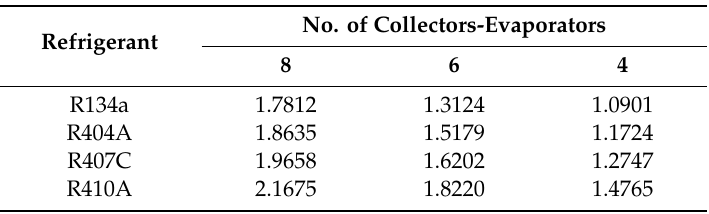
Table 4. Average annual thermal capacity during 4 h of